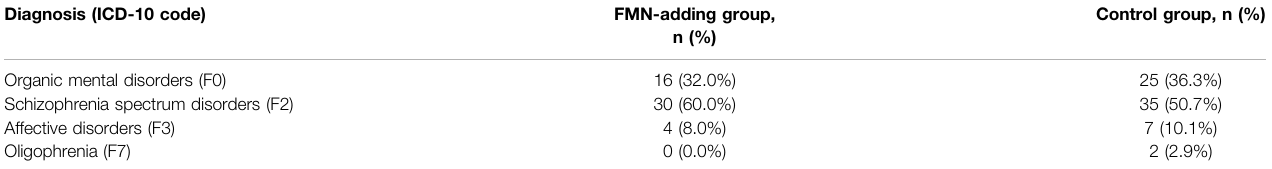
TABLE 2 | Distribution of the patients ( n = 119) according to ICD-10 diagnoses of mental disorders in the FMN-adding group ( n = 50) and control group ( n = 69). Diagnosis (ICD-10 code)